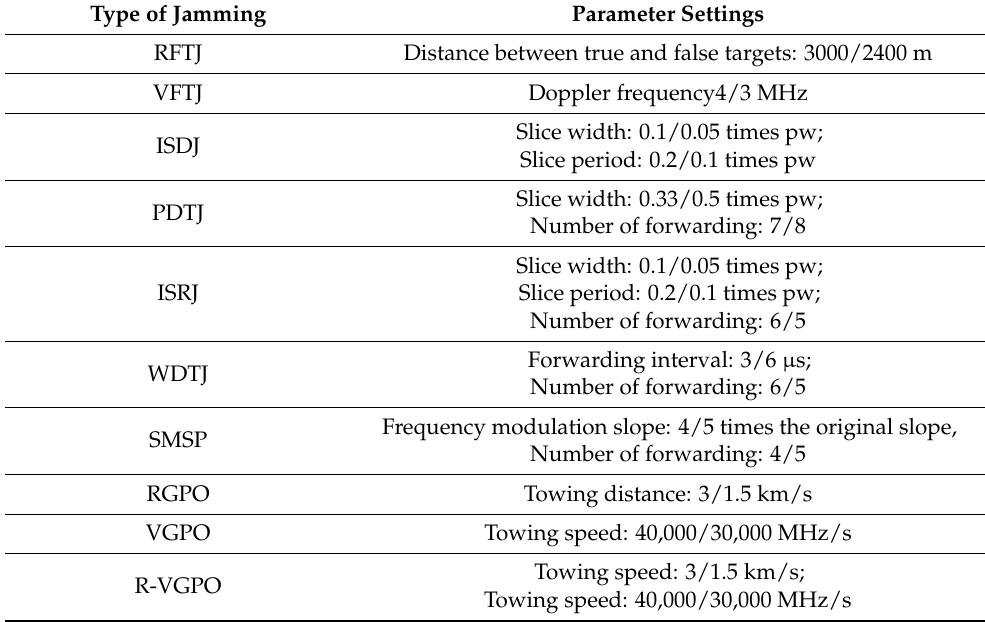
Table 4. Jamming